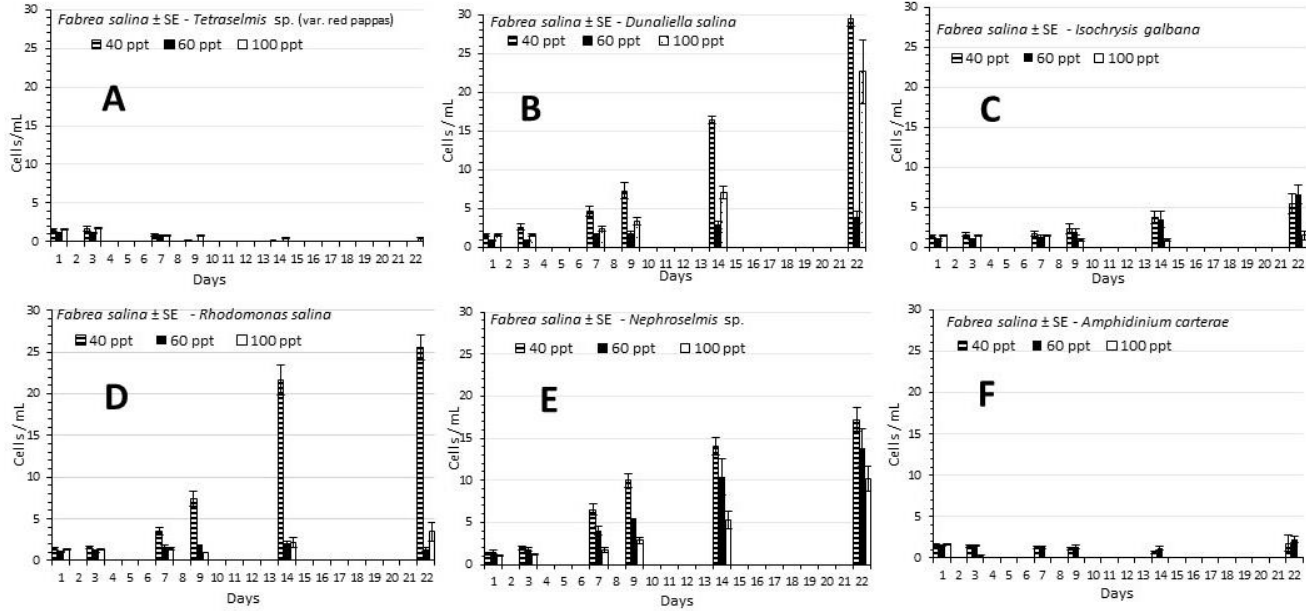
Figure 2. The development of the density ± SE of F. salina (cells/mL) in the different treatments of microalgae used at the salinities of 40, 60 and 100 ppt. ( A ) Tetraselmis sp. (var. red pappas), ( B ) Dunaliella salina , ( C ) Isochrysis galbana , ( D ) Rhodomonas salina , ( E ) Nephroselmis sp., ( F ) Amphidinium carterae .